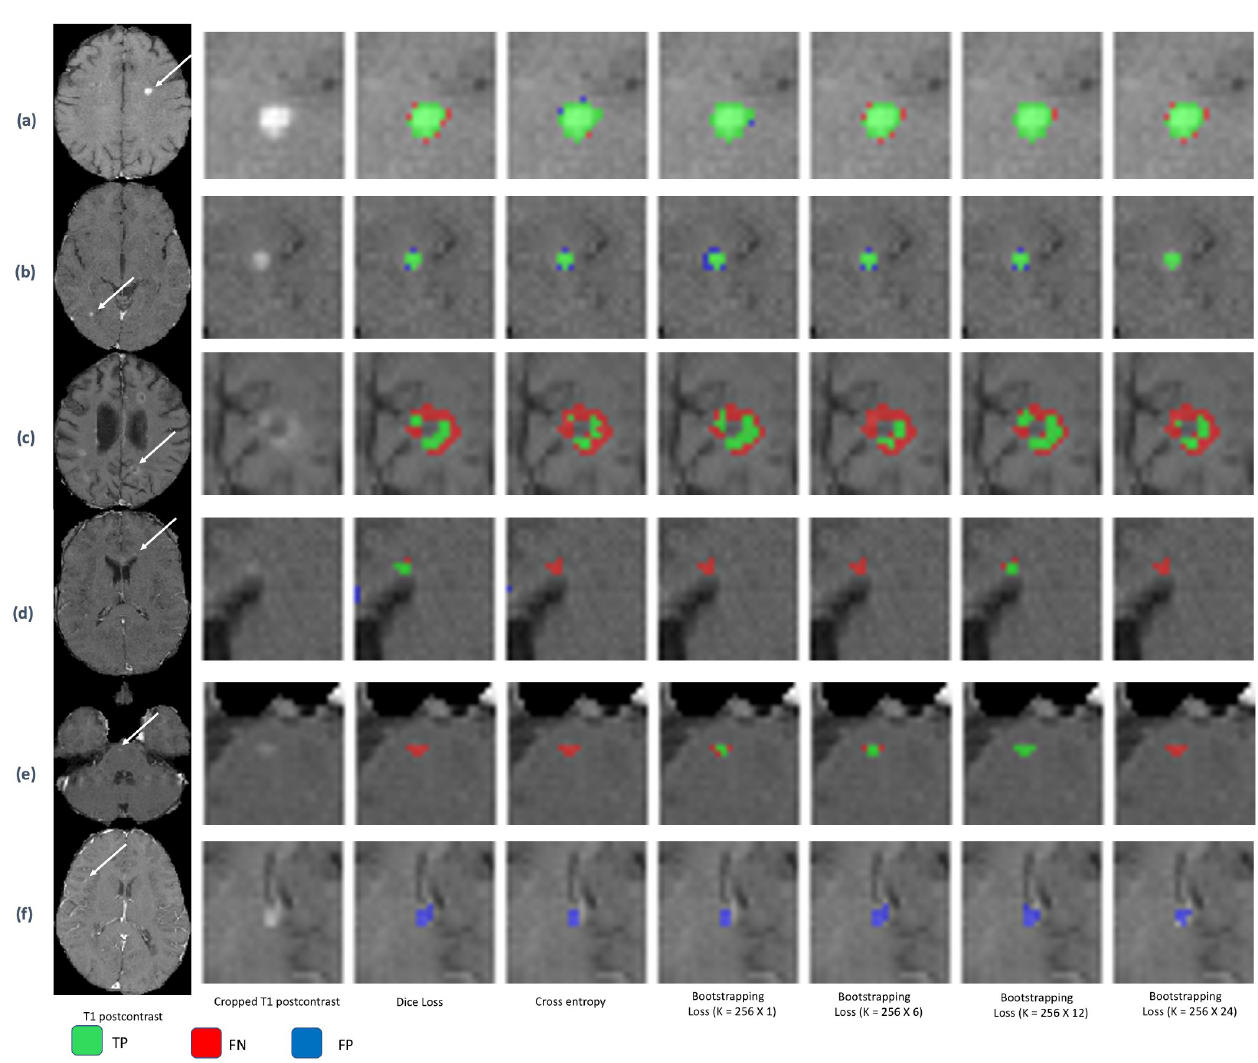
Fig 2. Predicted images for different loss functions. Each row represents image slices from different MRI sequences. The first column represents T1 post- contrast images and the second column represents the enlarged T1 post-contrast images around the lesion of interest. The other columns are performances of UNet and random forest model for different loss functions. Red regions are false negative segmentation, green areas are true positive, and blue regions are false positive regions. The white arrows are used to identify the lesion of interest. The first two rows (a and b) show example of lesions which are identified by all loss functions. The third row (c) shows change of lesion segmentation volume by loss functions. Fourth and fifth rows (d and e) show the improvement of segmentation due to bootstrapping loss function. The last row (f) shows example of false